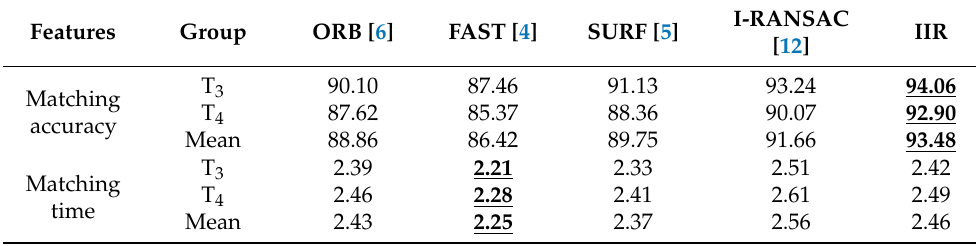
Table 7. A comparison of matching accuracy and matching time between different algorithms.